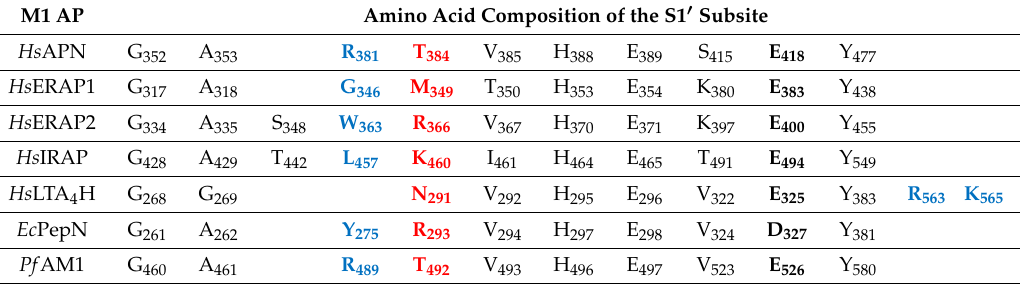
Table 6. S1’ subsite composition. Table 6. S1 (cid:48) subsite composition.